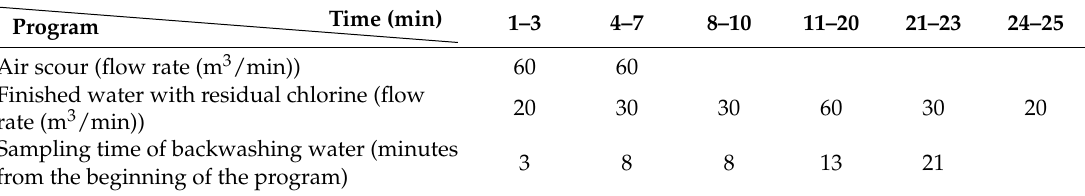
Table 1. Information regarding the backwashing program and the sampling times of the backwashing water